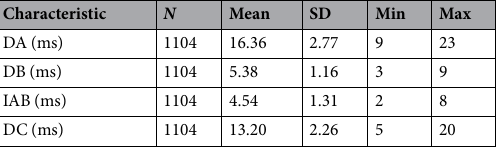
Table 1. Temporal characteristics of sounds produced by females of Subpsaltria yangi . Characteristics: DA, duration of component A; DB, duration of component B; IAB, interval between component A and component B; DC, duration of component C.